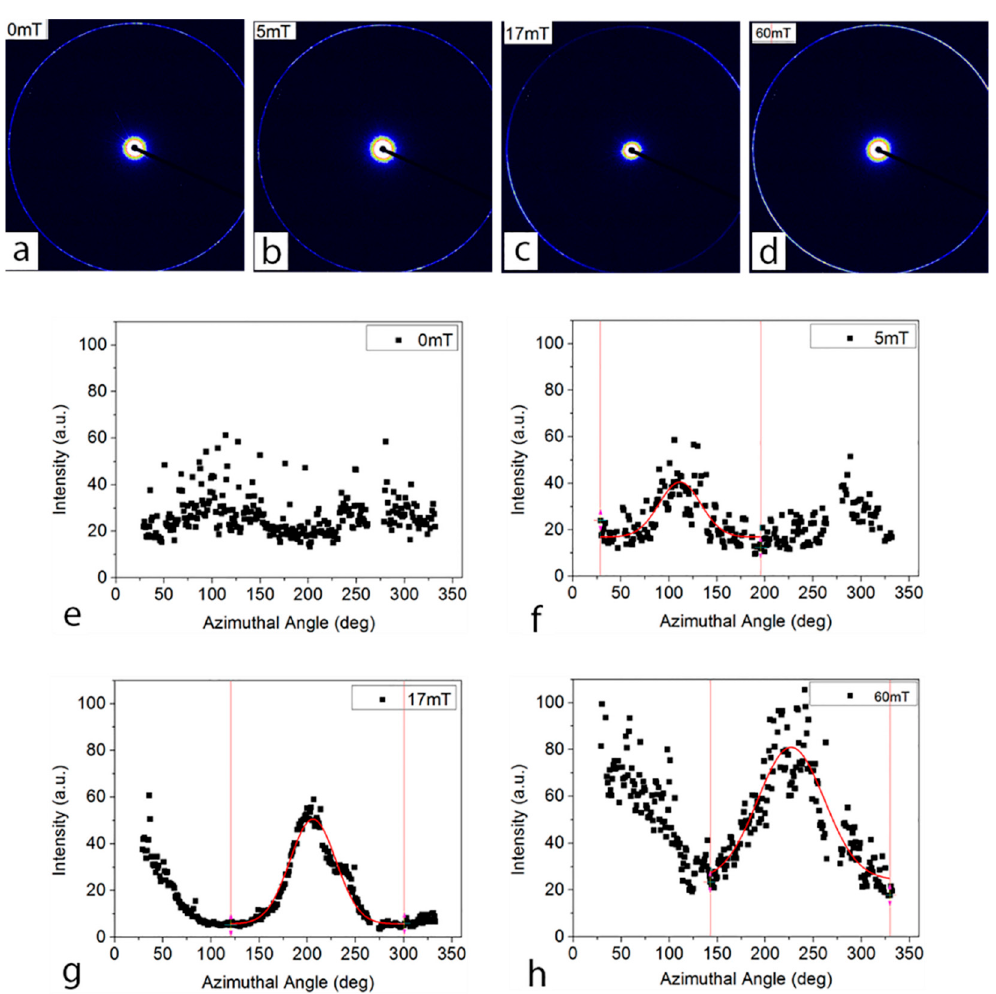
Figure 5. Structure alignment in the resulting polymer films. ( a – d ) Two dimensional SAXS patterns; and ( e – h ) Corresponding azimuthal intensity of the primary Bragg peak for polymer films templated with hexagonal LLC aligned under 0, 5, 17, and 60 mT, respectively.